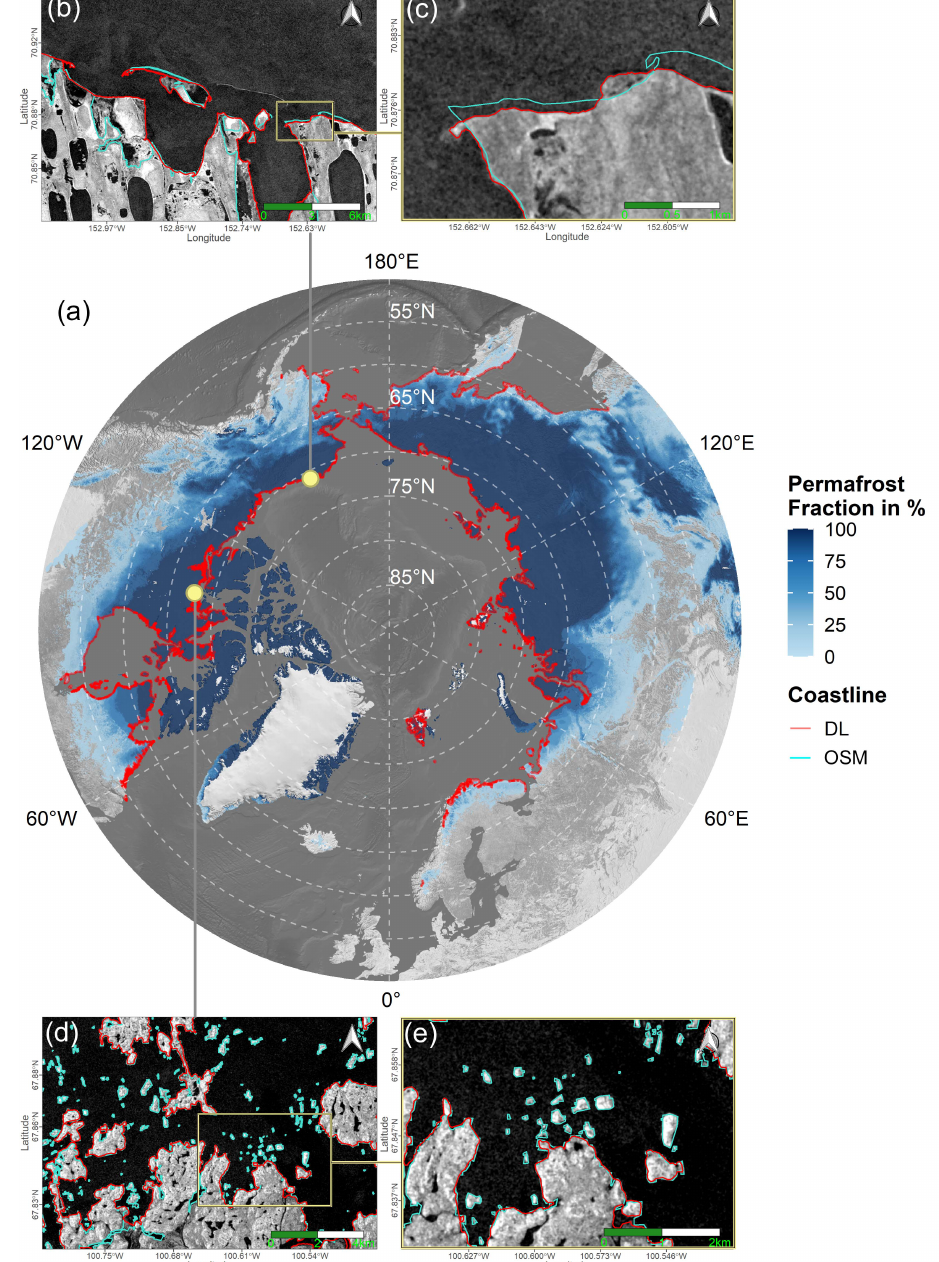
Figure 9. Circum-Arctic overview ( a ) and zoom-ins ( b – e ) on the Deep Learning (DL) coastline product (red line) and the OpenStreetMap (OSM) coastline (turquoise line) for the two different example regions Drew Point in Alaska ( b , c ), and an area in the Canadian Arctic Archipelago ( d , e ). The median Sentinel-1 (S1) backscatter in vertical-vertical (VV) polarization for the months June–September in 2020 was used as a background image for ( b – e ). The permafrost fraction across the Northern Hemisphere for the year 2017 based on data by Obu et al. [52] in combination with a shaded relief by Natural Earth [58] was utilized as a background map for ( a